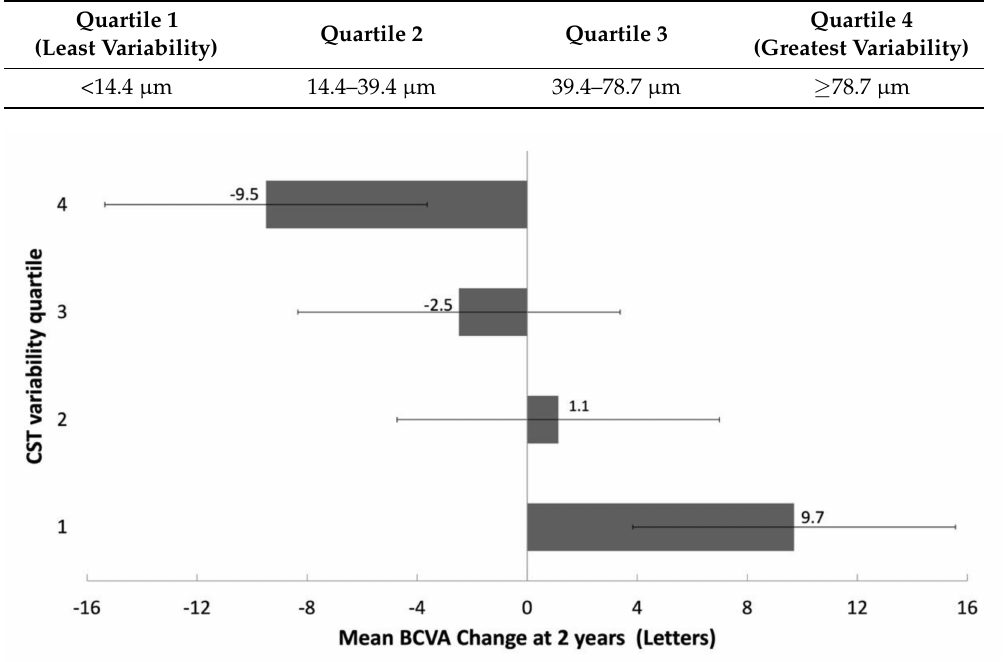
Figure 2. Mean BCVA change at 2 years for the CST variability quartile groups (error bars represent the 95% confidence